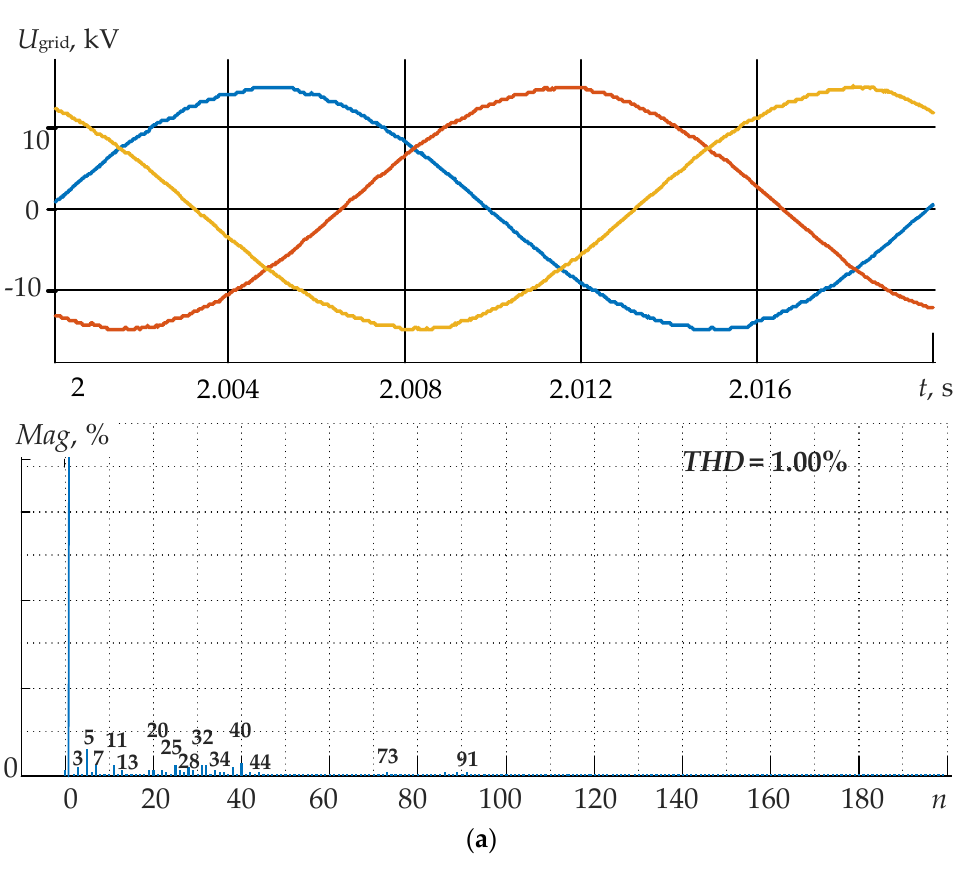
Figure 2. Measuring complex.